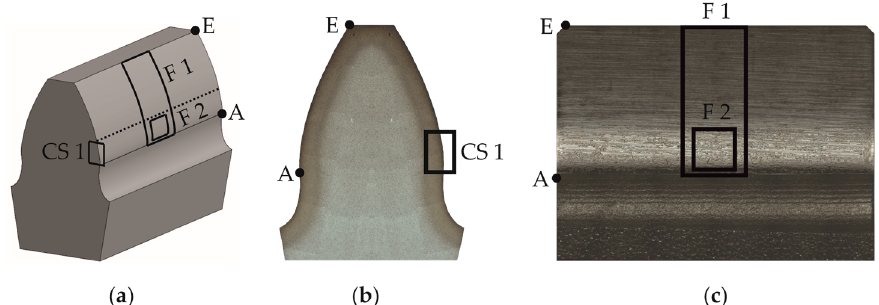
Figure 2. Areas of interest: ( a ) Three-dimensional scheme; ( b ) Cross-section; ( c ) Front view of the flank. CS: Cross-section; F: Flank; A: Used tooth root diameter; E: Tooth tip.